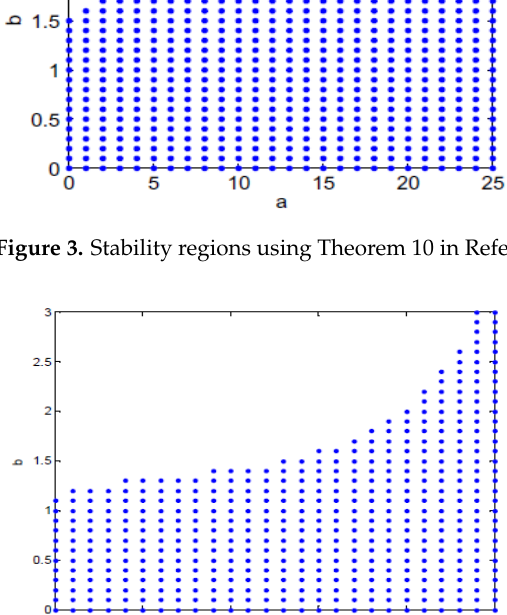
Figure 4. Stability regions for m = 4 and δ = 0.08.